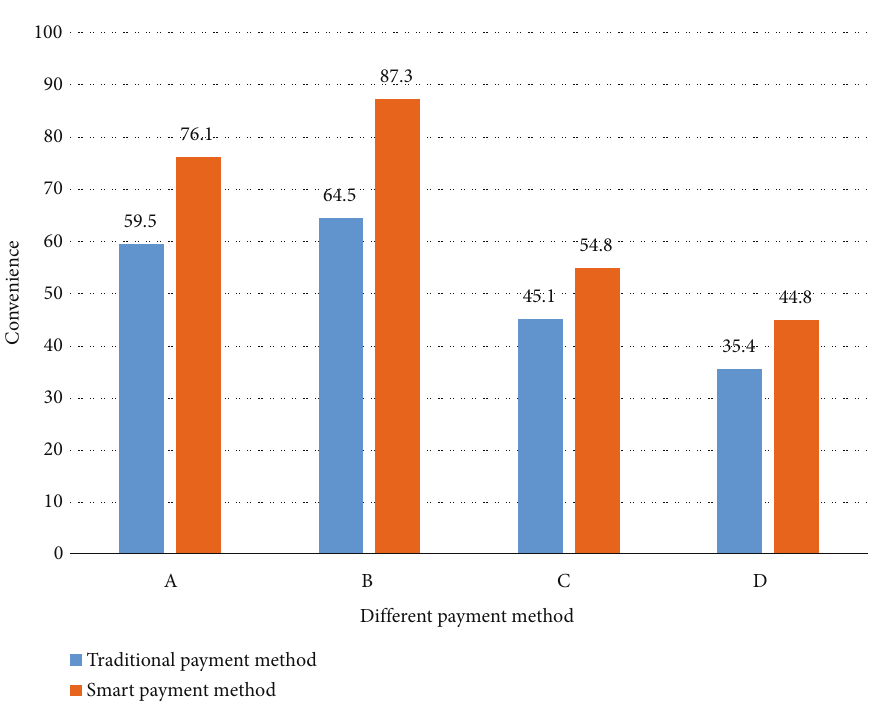
Figure 4: Comparison of two di ff erent payment methods.